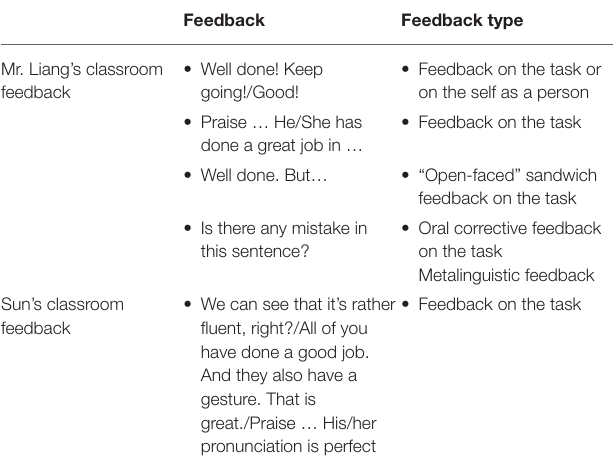
TABLE 5 | Oral feedback patterns of Sun and his associate teacher Mr.